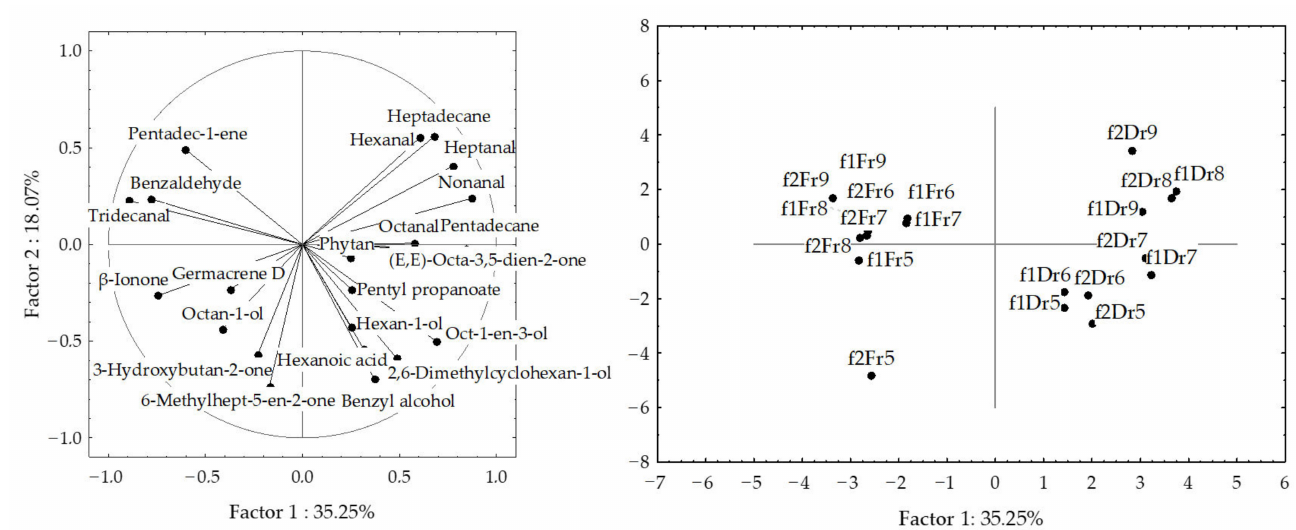
Figure 6. Correlation and score plots of the dominant compounds from headspace volatiles (two different fibres for HS-SPME/GC–MS: divinylbenzene/carboxene/polydimethylsiloxane (f1) and